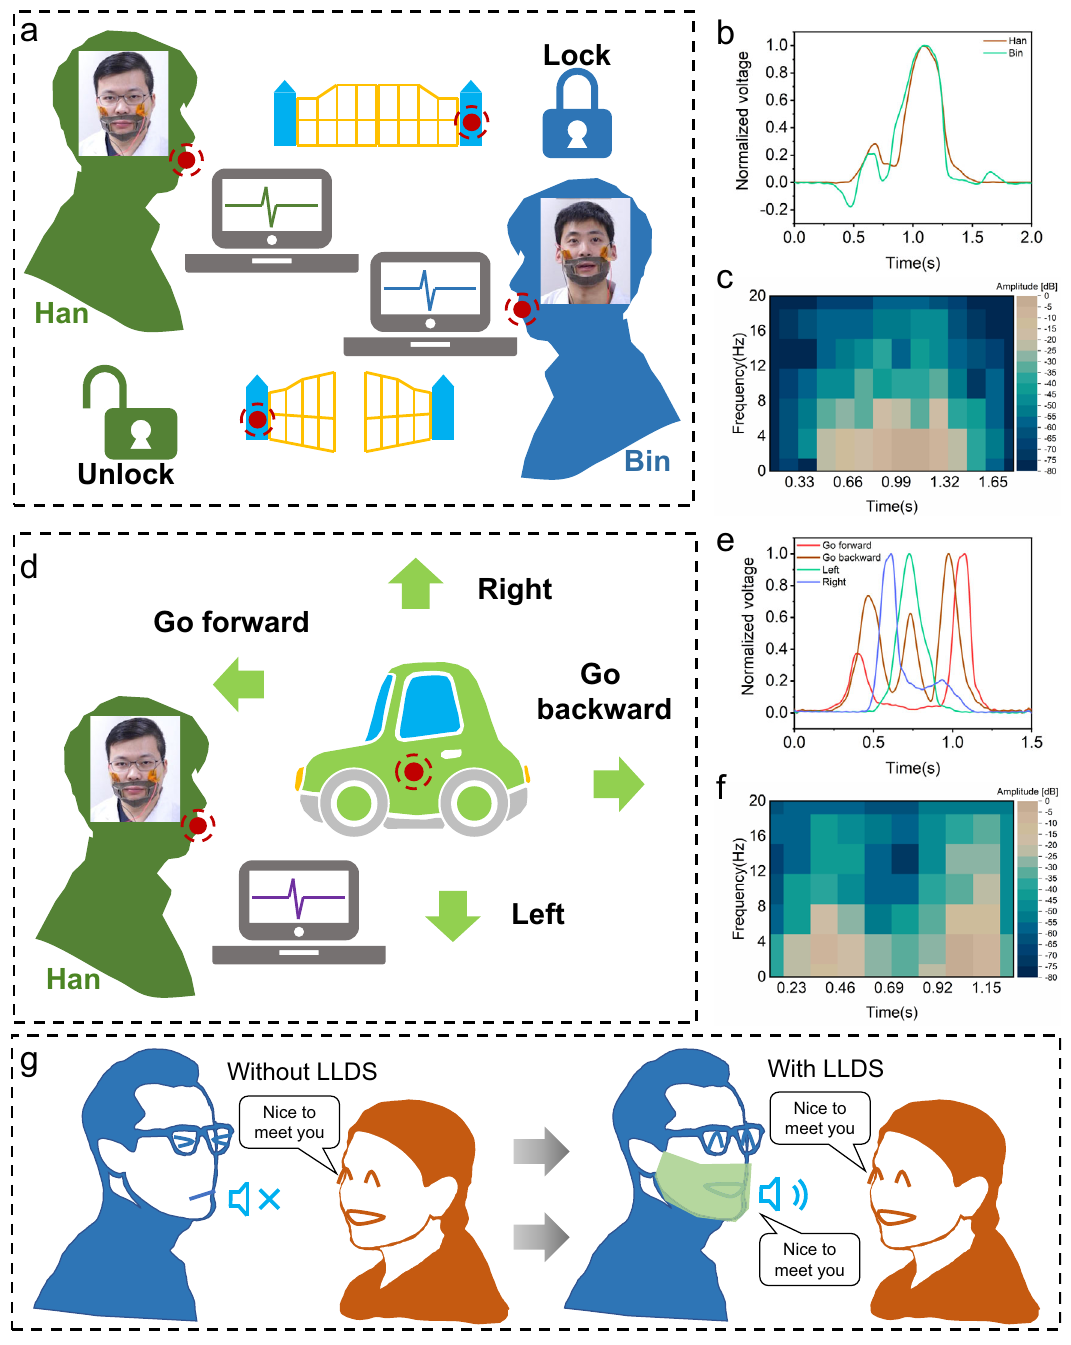
Fig. 5 The applications for lip-language decoding in personal identity veri fi cation (PIV), toy-car control and lip motion to speech conversion for assisting with communication for people lacking a voice. a Schematic diagram of unlocking a gate by lip motion with personal identity veri fi cation. b A comparison of lip-motion signals from participants (Han and Bin) in the time domain. c Short-time Fourier transform (STFT) analysis of the lip-motion signals from Han. d Schematic diagram of direction control for toy car motion by lip motion. e Comparison of lip-motion signals from Han in the time domain. f STFT analysis of the lip-motion signals for ‘ Go forwards ’ from Han. g Schematic diagram of the daily voice communication for people lacking a voice with and without lip-language decoding system